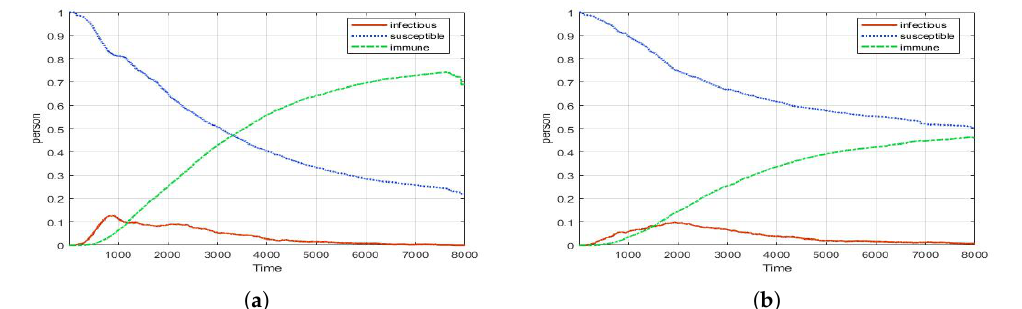
Figure 11. Experimental results for Screening + vacation rate + PCR test (long-term): ( a ) Long 15%, Short 10% (peak: 0.1); ( b ) Long 0%, Short 10% (peak: